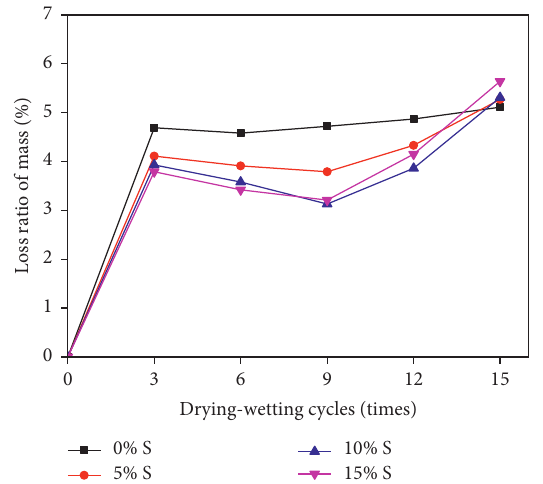
Figure 5: Residual strength ratios of CGFB samples under sulfate attack of drying-wetting